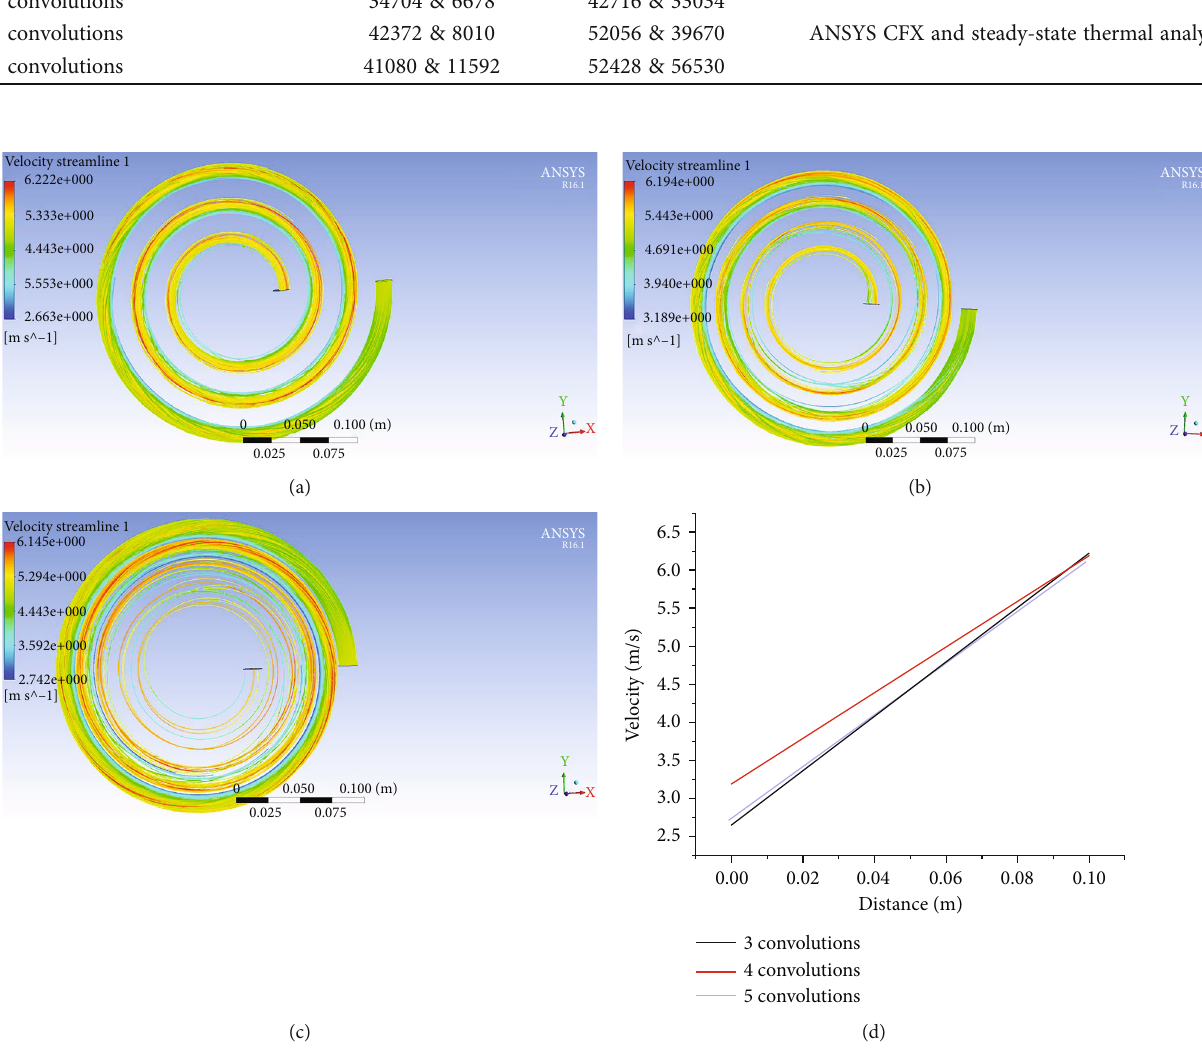
Figure 3: Streamlines of fl ow through coil of (a) three convolutions, (b) four convolutions, (c) fi ve convolutions, and (d) velocities of streamlines at di ff erent positions of coil with varying number of convolutions.